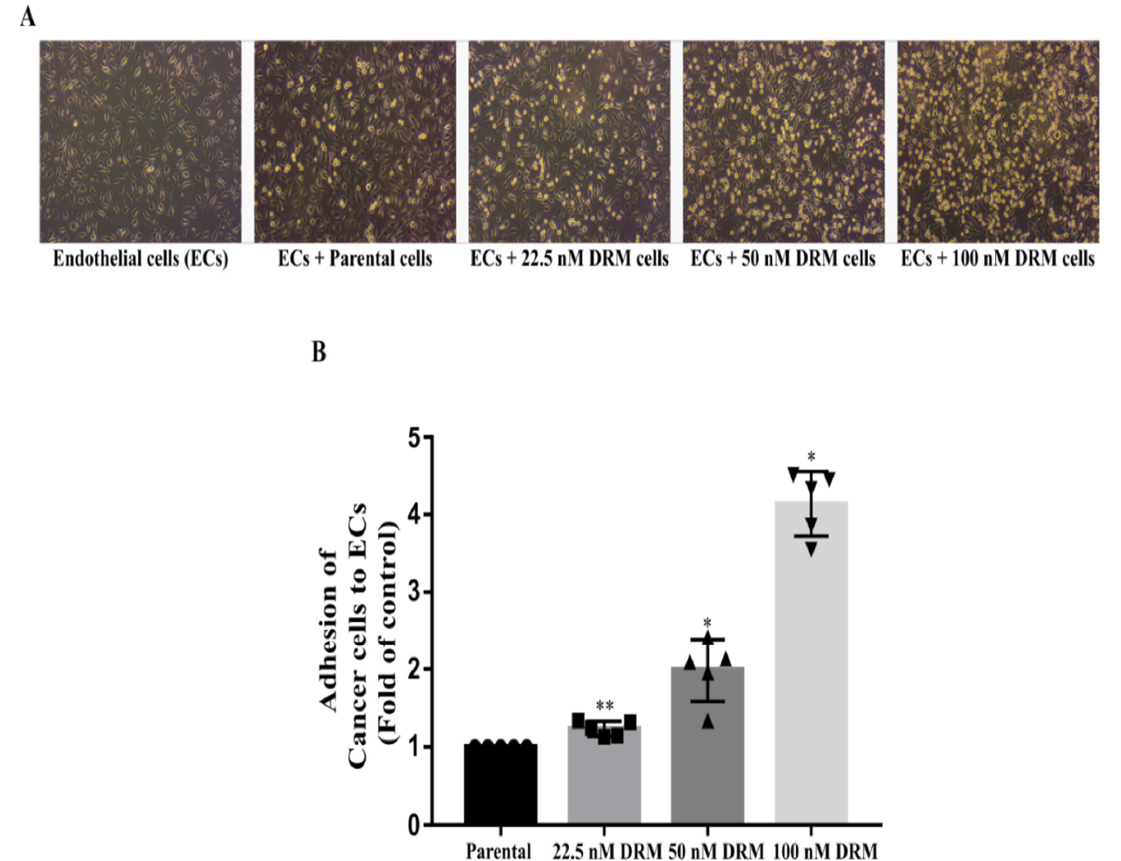
Figure 6. Doxorubicin-resistant cells have a high adhesion effect to umbilical vein endothelial cells (ECs). The adhesion of DRM cells to Endothelial cells (ECs) was significantly increased with the advancement of resistance to higher concentrations of doxorubicin. The cells were washed, and the resistant cells adhered to ECs were counted. ( A ) The attached cells were photographed using a light microscope ( B ) Graphical representation of a number of cells attached. The values expressed as mean ± standard deviation (SD) (n = 5) (* p < 0.05, ** p < 0.001 vs. control). DRM: Doxorubicin-resistant MDA-MB-231.